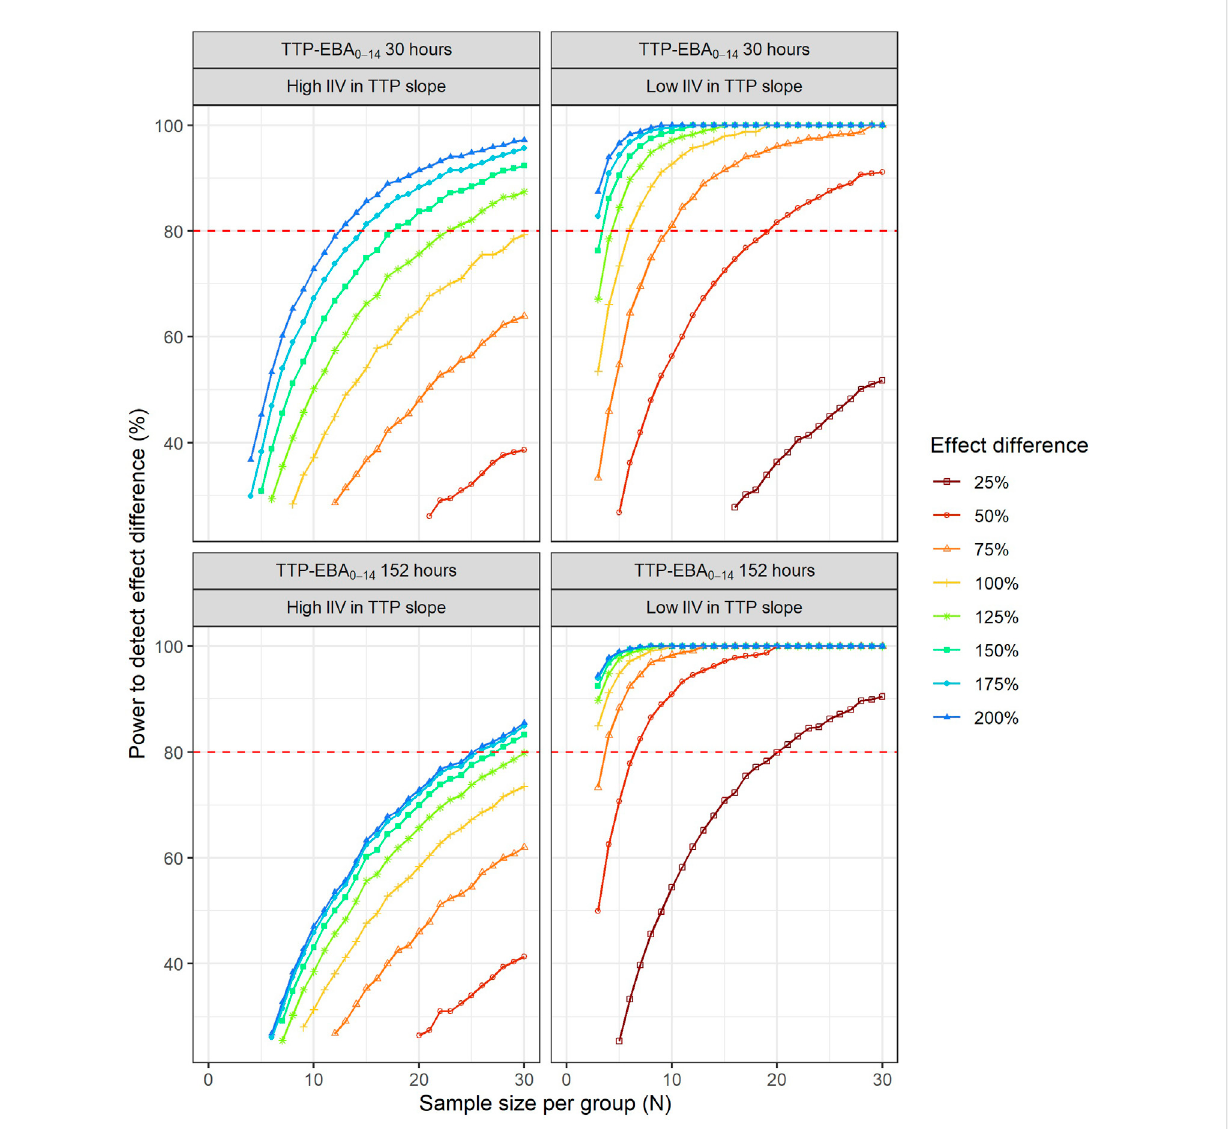
FIGURE 10 The impact of effect difference on the sample size and power to detect a difference between two treatment groups. Low and high inter-individual variability (IIV) in early bactericidal activity (EBA) are represented by 22% and 104% coef fi cient of variation, respectively. The red dashed line represents 80%